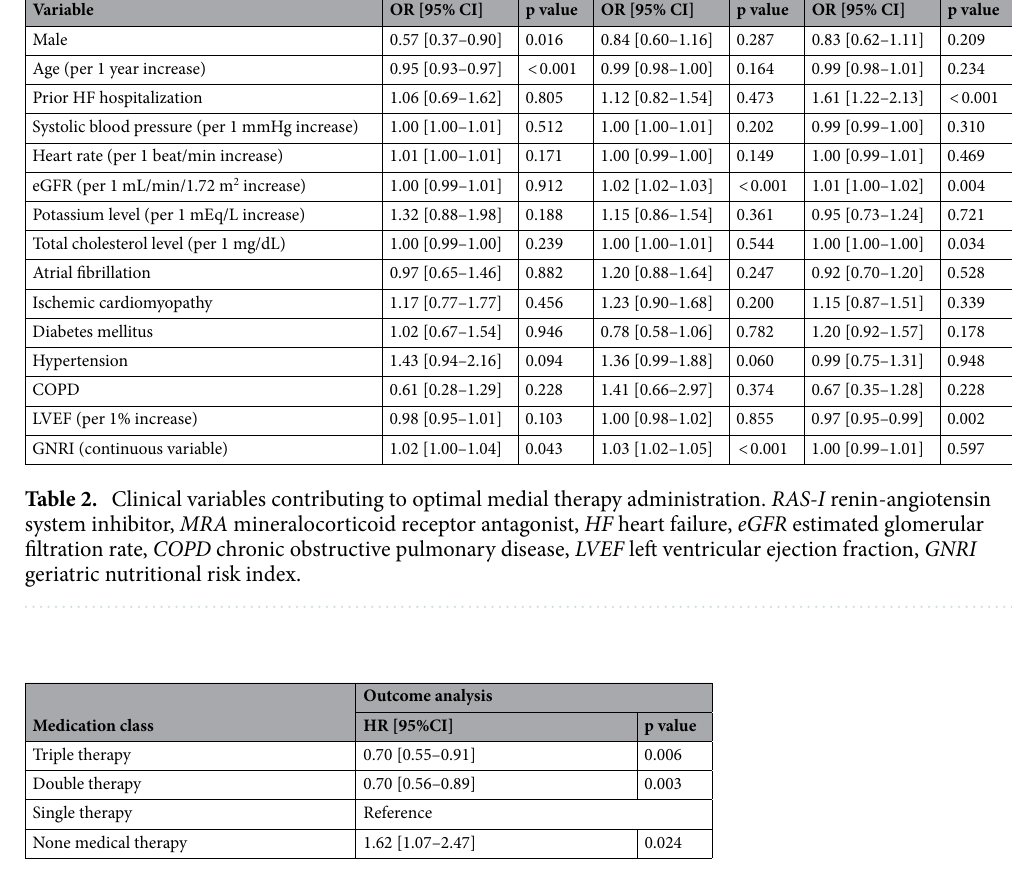
Table 3. Multivariable Cox proportional hazards models of the primary outcome. These models were adjusted by the following variables: age, sex, systolic blood pressure, heart rate, renal dysfunction (eGFR < 60 ml/ min/1.73m 2 ), ejection fraction, history of heart failure hospitalization, ischemic etiology, atrial fibrillation, chronic obstructive pulmonary disease, stroke, diabetes mellitus, use of loop diuretics, use of statins and medical therapy (triple, double, single, and no optimal medical therapy), as well as geriatric nutritional risk index. BB beta-blocker, RASi renin-angiotensin system inhibitor, MRA mineralocorticoid receptor